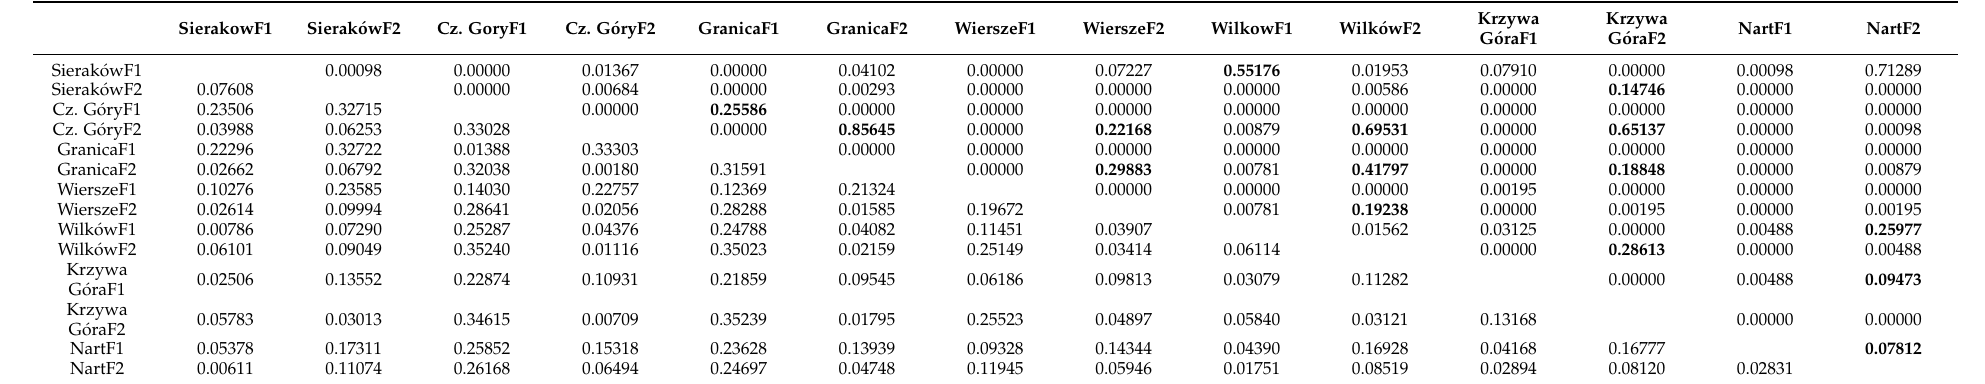
Table 4. The genetic differentiation ( F st) between populations analysed (below diagonal) and their statistical significance ( p values) (above diagonal) results in bold are not statistically